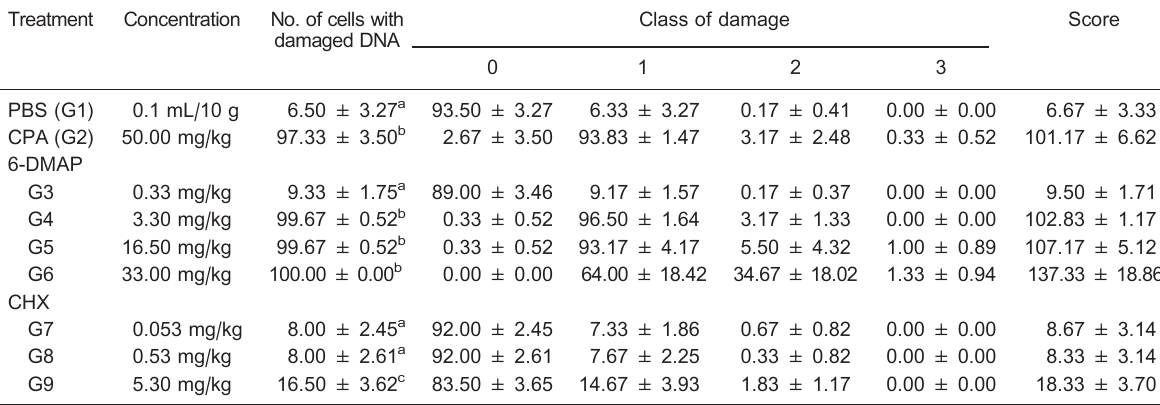
Table 4. Means±SD of cells with damaged DNA, distribution between classes of DNA damage, and score from blood of mice in the comet assay.